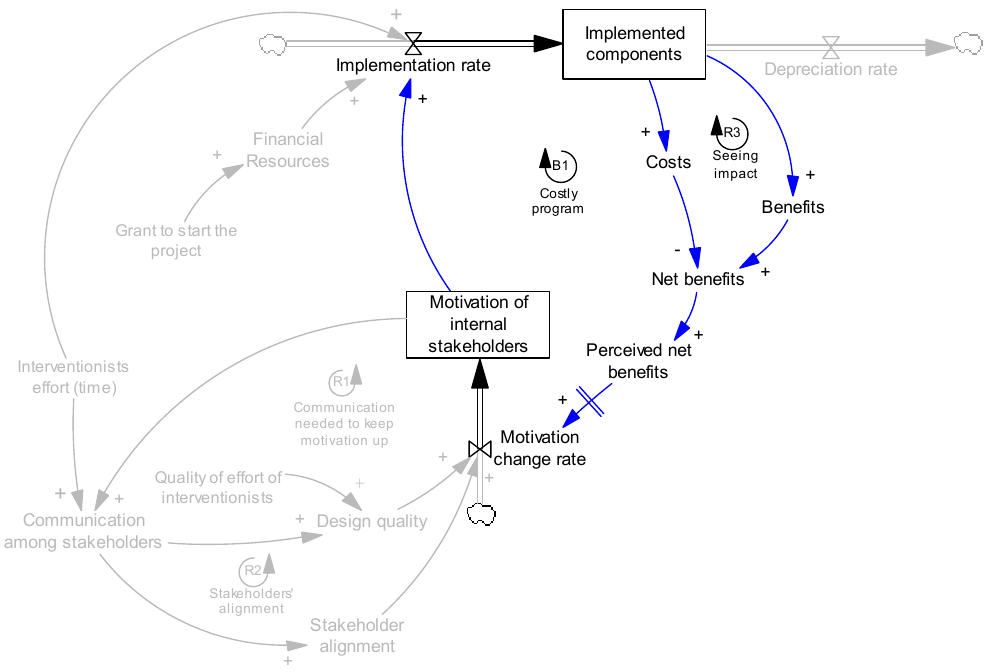
Figure 5. Effects of costs and benefits on motivation. B1 presents a balancing feedback loop, where a perturbation in one variable is attenuated once we trace its impact across the loop back to the original